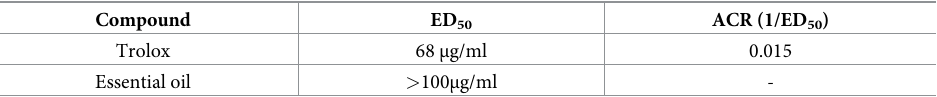
Table 3. Results of antioxidant activity performed with DPPH method (DPPH free radical scavenging